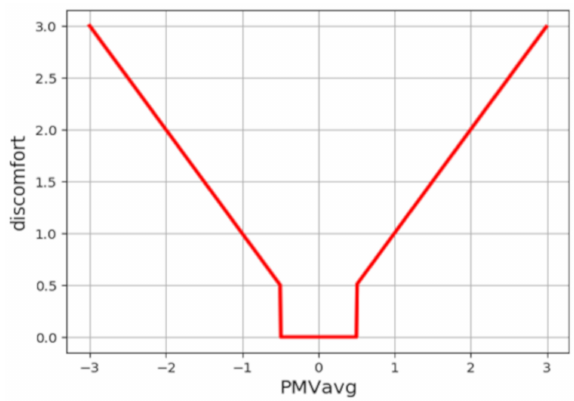
Figure 6. Thermal